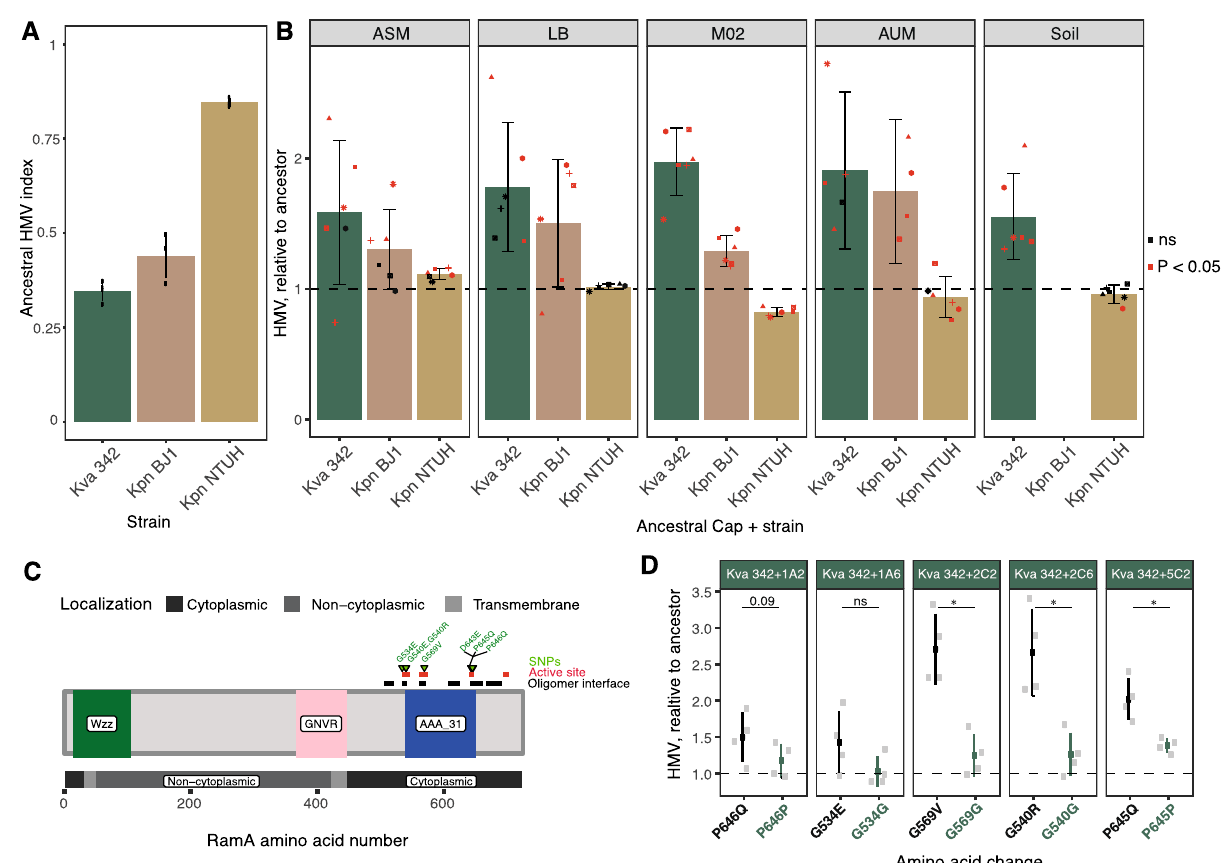
Fig. 5 | Hypermucoid phenotype of ancestral and evolved clones of Klebsiella . A HMP expressed as hypermucoviscosity (HMV) index of the ancestral clones. The bar represents the mean of three independent biological replicates (indi- vidual points) and error bars indicate a 95% interval of con fi dence. B Hypermucoidphenotypeofindependentclonesrelativetoitsancestor.Values over one re fl ect increased HMP. Bars represent the average HMP within treat- ment and error bars indicate standard deviation from the mean (Treatment statistics provided in Table S1). Each dot re fl ects the average of at least three independent biological replicates of each independently evolving population. Individual error bars for each dot are not presented for clarity purposes. Red dots highlight clones which are signi fi cantly different from the ancestor, One-